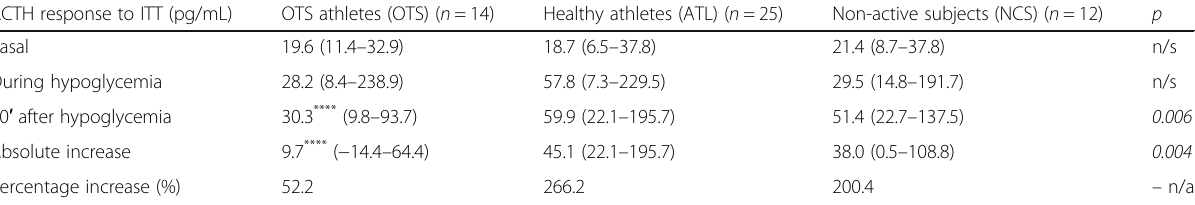
Table 3 Median (95% CI) ACTH response to insulin tolerance test (ITT) ACTH response to ITT